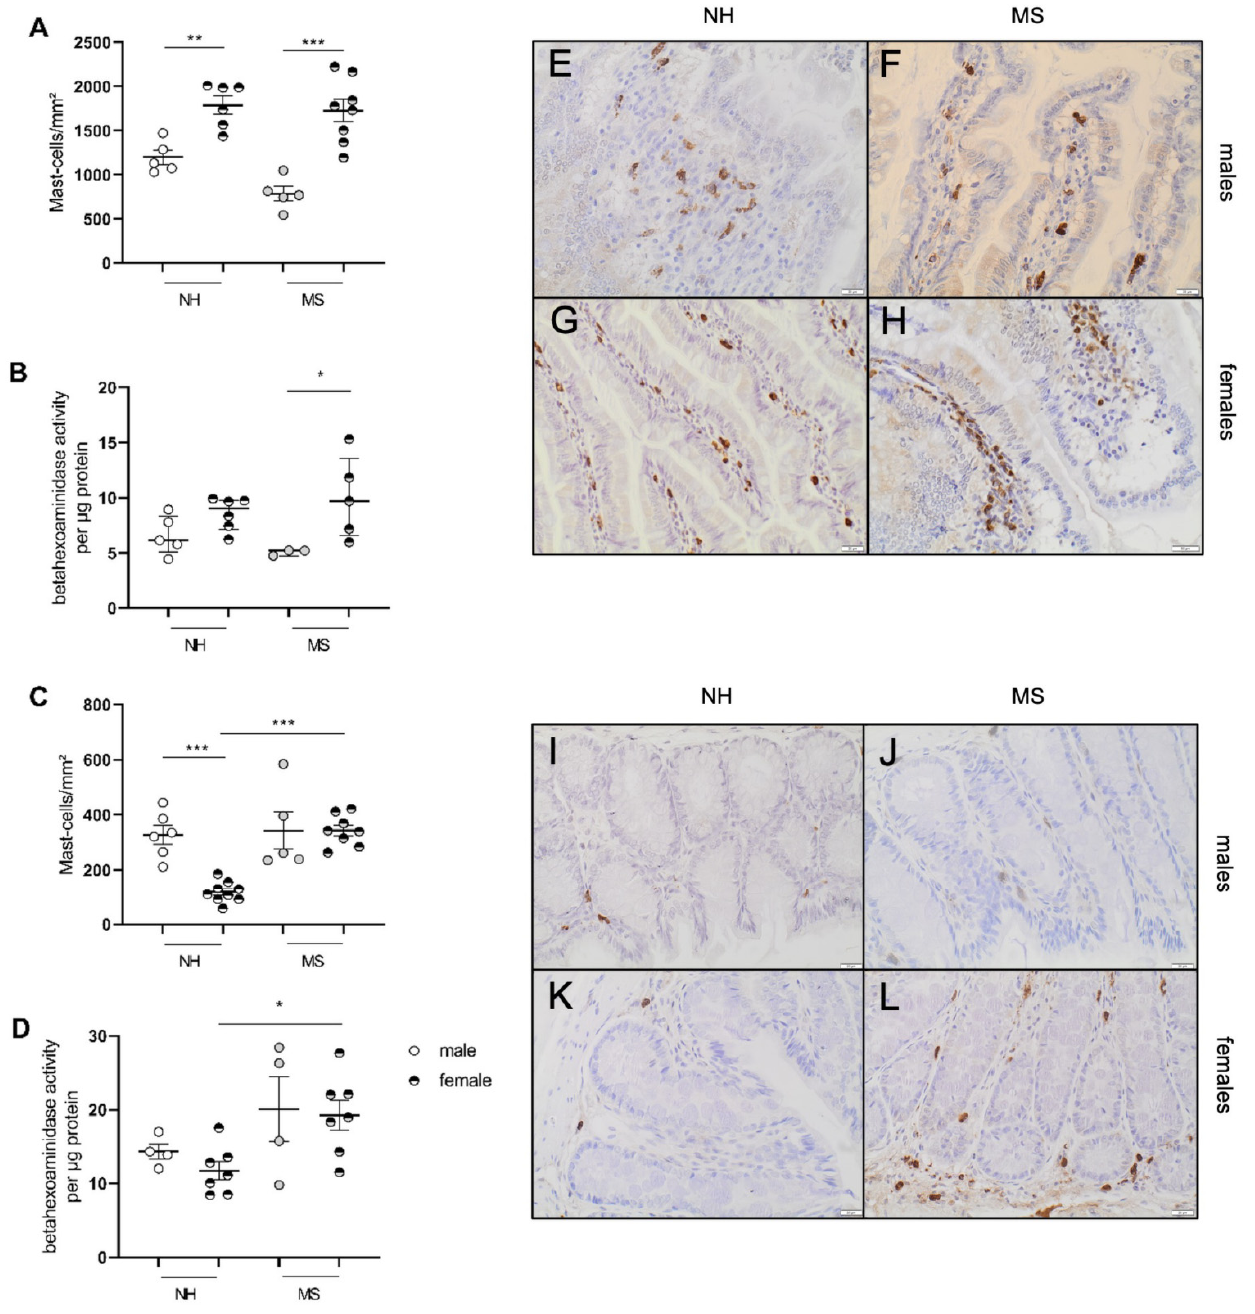
Figure 3. Mast cell infiltration and activation in the jejunum and colon after maternal separation. Mast cells stained by anti-protease II in the jejunum ( A ) and the colon ( C ) of BBDPN males and females. Activation of mast cells assessed in the jejunum ( B ) and colonic mucosa ( D ). Representative pictures of the jejunum of male NH ( E ); female NH ( F ); male MS ( G ); female MS ( H ) and for the colon of male NH ( I ); female NH ( J ); male MS ( K ); female MS ( L ). Data are presented as mean ± SEM ( A , C ) or median ± IQR ( B , D ). * p < 0.05; ** p < 0.01; *** p < 0.001. NH—nonhandled; MS—maternal separation. n = 3–9 per group .